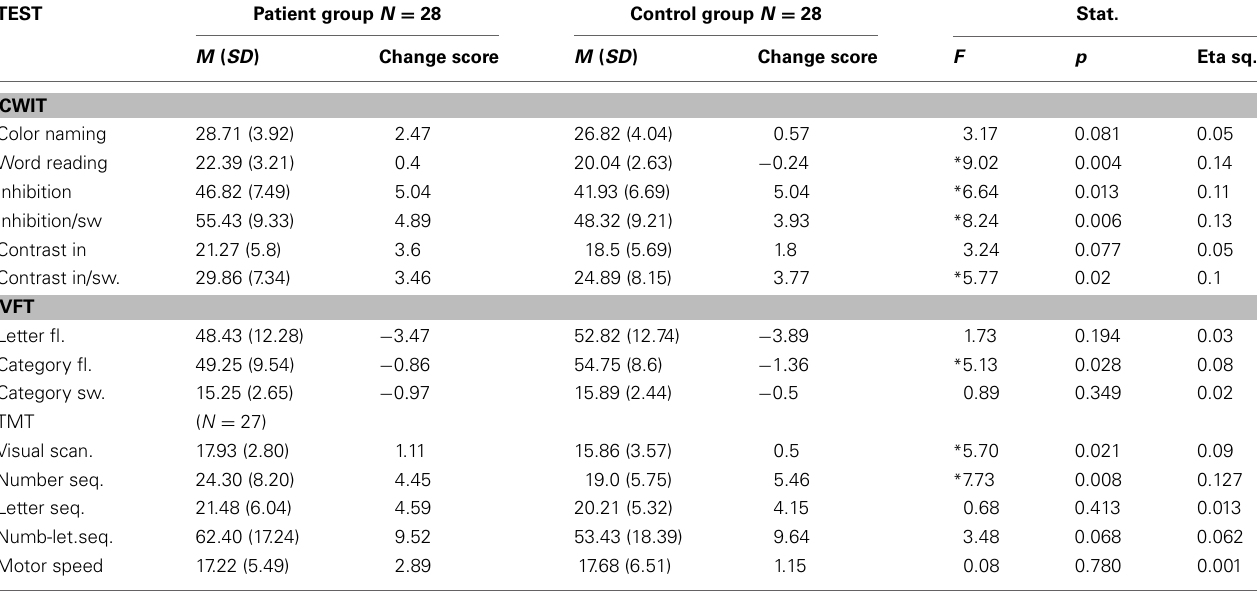
Mean (M), standard deviation (SD) and change score (raw score) from T1 to T2. Statistics (F, p, Eta sq.) on differences between groups at T2. * Significant